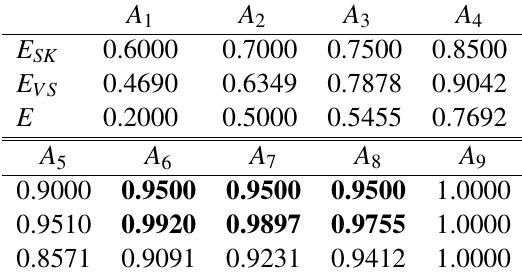
Table 1 Comparison of